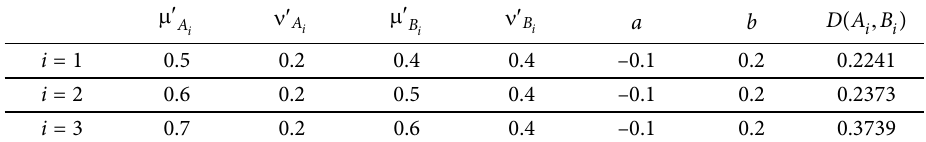
Table 3. Another numerical example of the spherical distances based on equal Euclidean